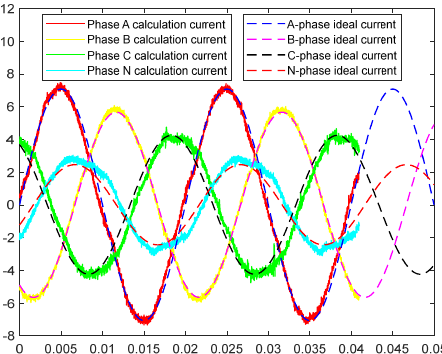
Figure 15. Comparison of reduced current waveforms with theoretical current waveforms. Table 3. The error between the reduction current and the theoretical current. Phase